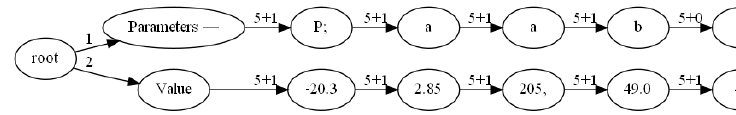
Figure 14. Tree for scanned table image 1.